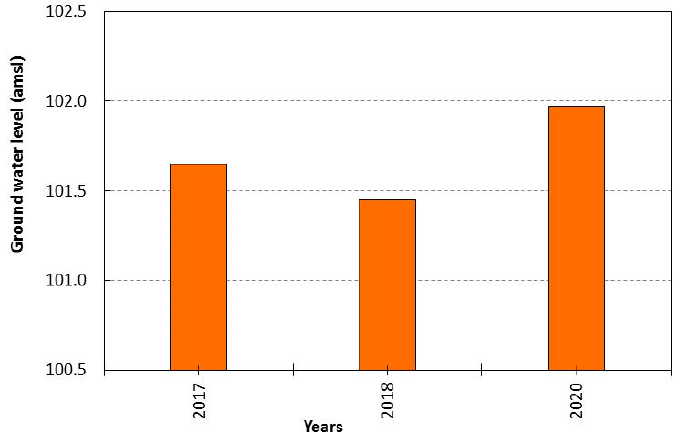
Figure 7. The relation between years and Kima Lake water